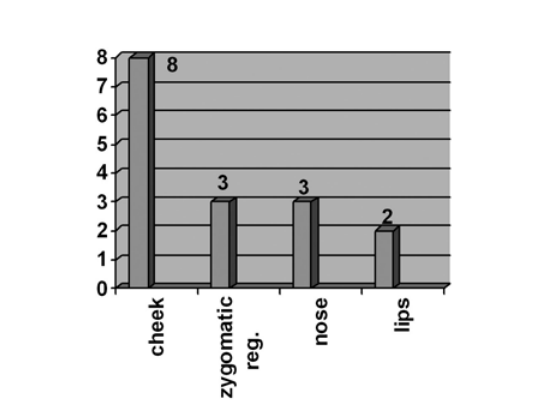
Figure 5. Localization of human bite injuries that occurred during physical